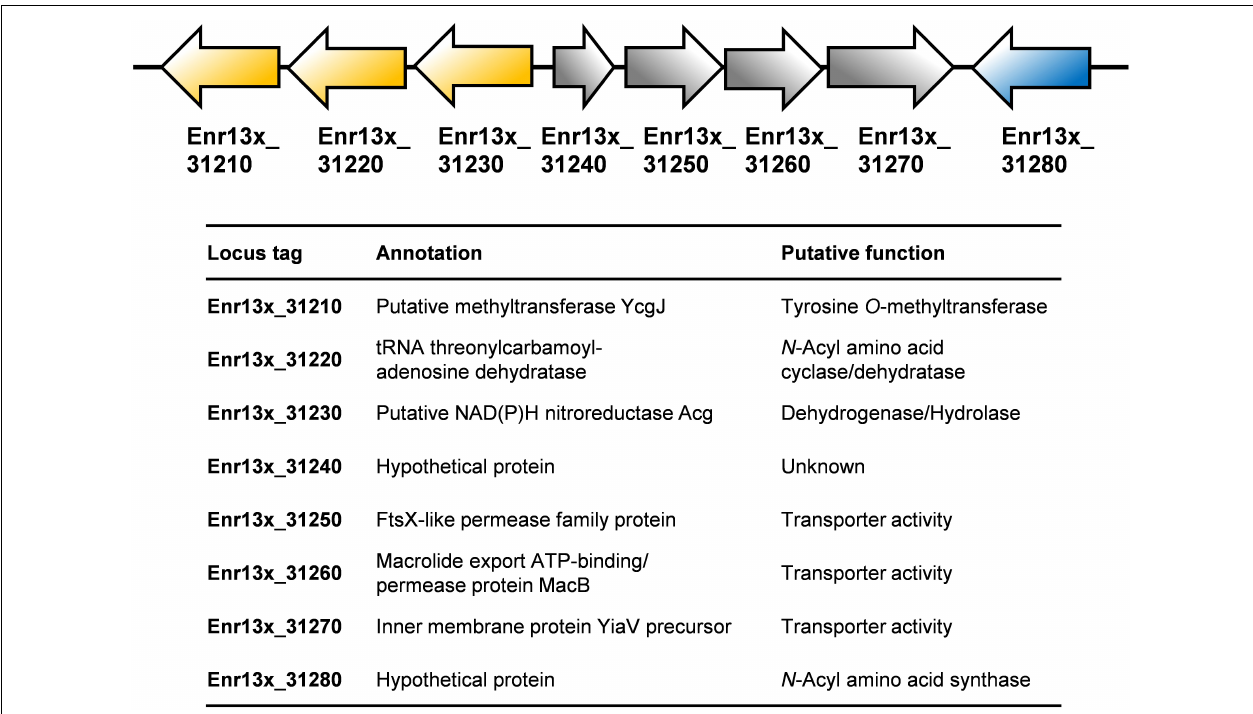
FIGURE 6 | Putative stieleriacine biosynthetic gene cluster. The organization of the genes in the cluster is depicted. For encoded enzymes, the putative enzyme function/protein activity is given. Same colors do not indicate polycistronic operons (no information on the expression pattern is available).